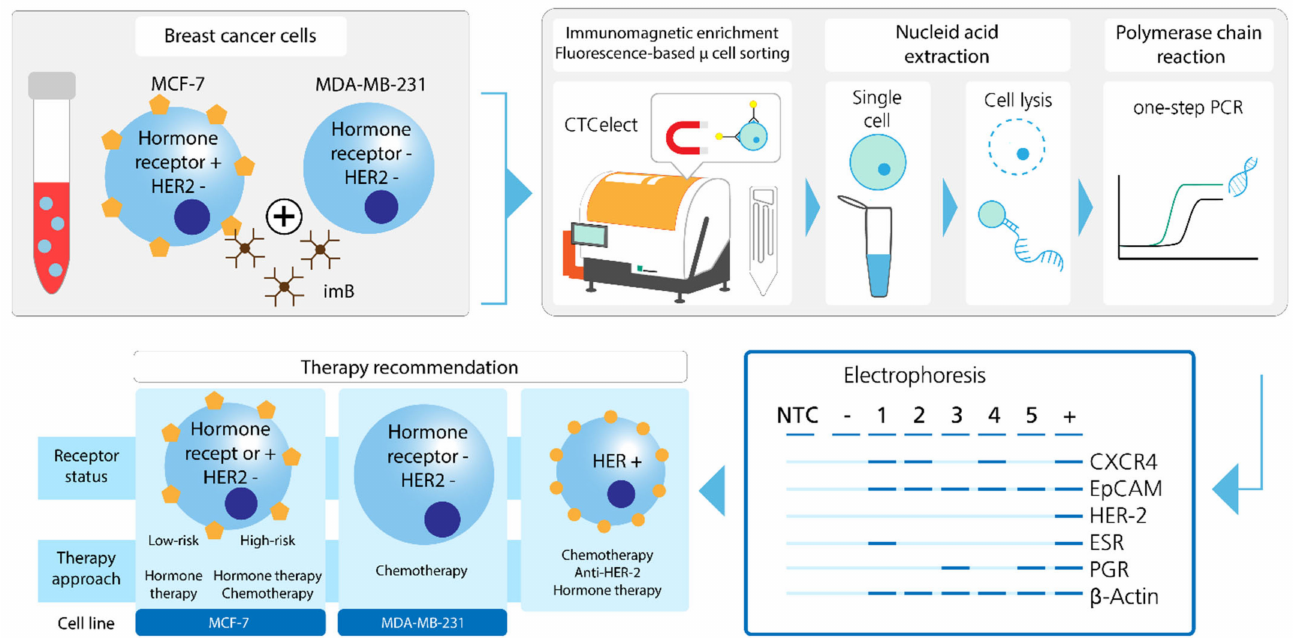
Figure 1. Automated isolation workflow of single tumor cells for the molecular analysis of different cancer-associated markers and their diagnostic and therapeutic potential. After enrichment with immunomagnetic beads (imB) and fluorescence-based microfluidic cell sorting of cancer cells from a 7.5 mL sample, single cell RNA is analyzed using RT-PCR and electrophoresis. In dependency of different markers, tumor subtypes and respective therapy approaches can be potentially